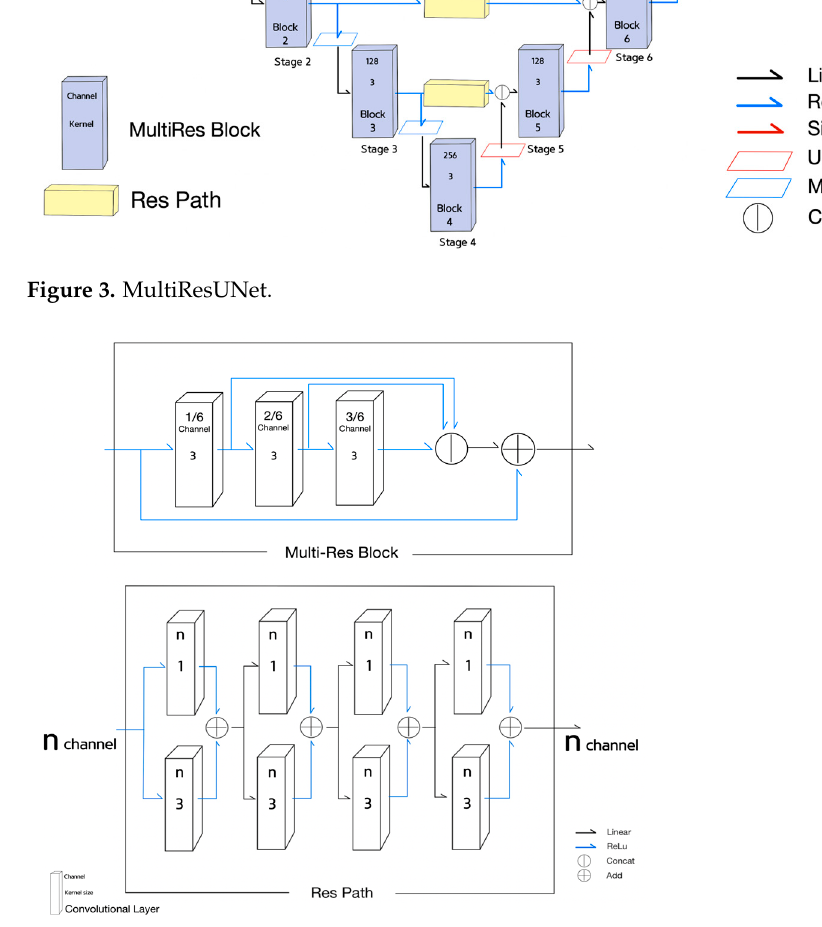
Figure 4. MultiRes block and residual path in MultiResUNet.